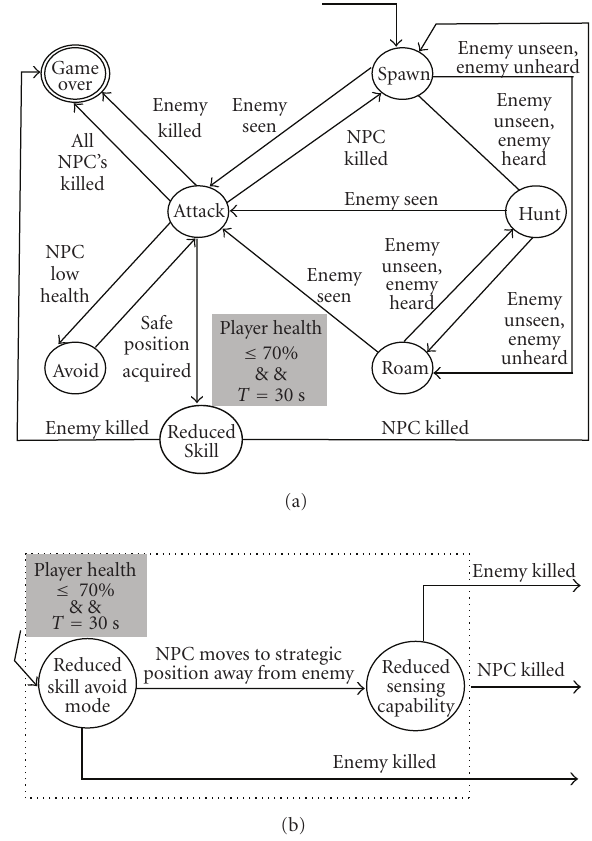
Figure 6: (a) Proposed reduced skill nonplayer character action finite state automaton. (b) “Reduced Skill” finite state detailed. validate, and implement these together with the successful recognition that has already been